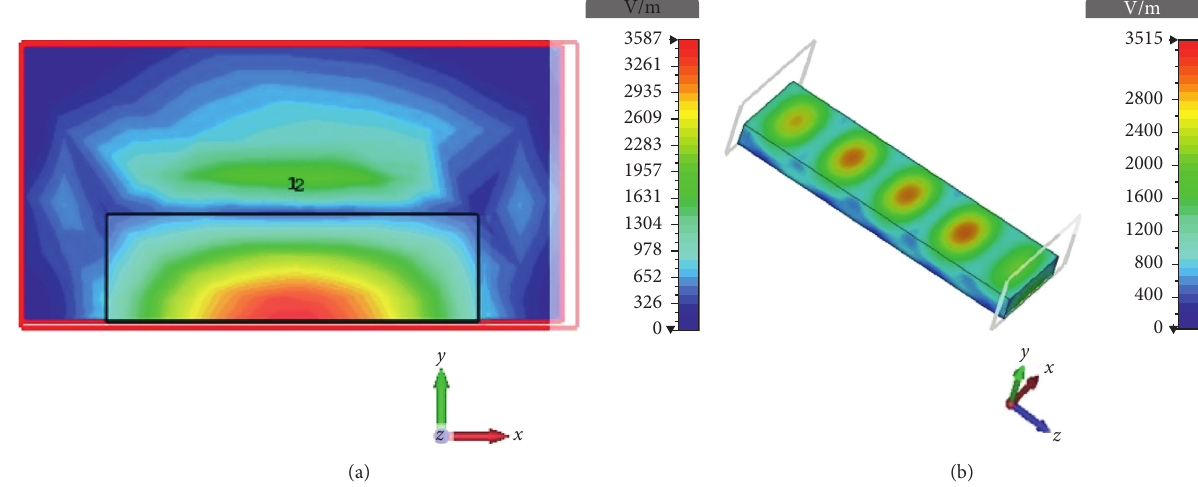
Figure 3: E y 11 mode of the dielectric image guide: (a) port mode field and (b) propagation mode field.